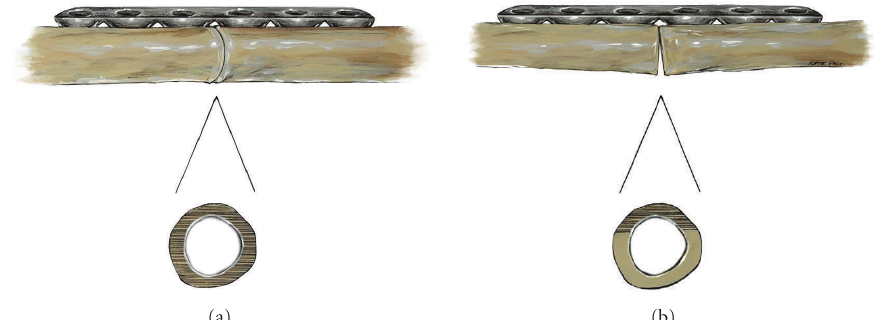
Figure 2: Scheme of femoral sawbones under compression plating at the simulated allograft-host junction site (SAHJS). Images demonstrating 100% contact (a), minimal contact with gapping (b).